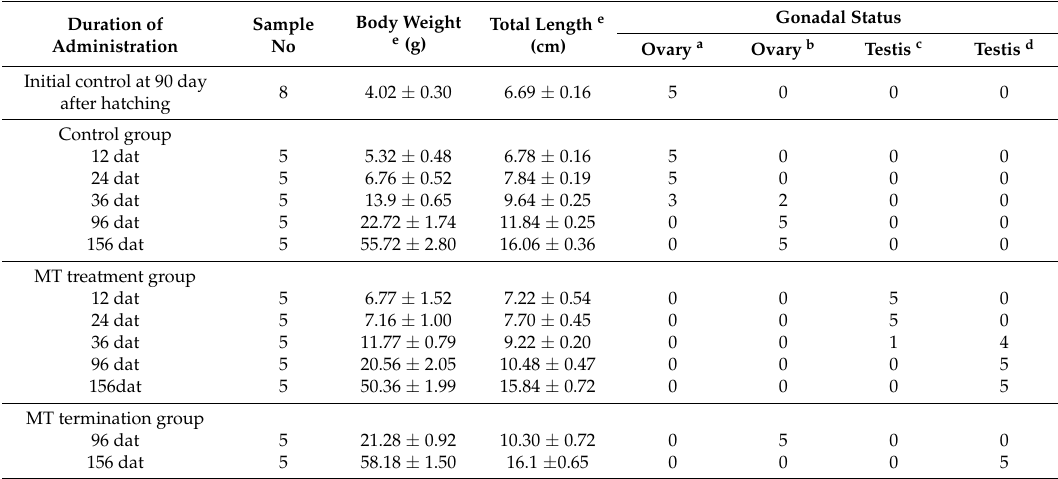
Table 1. The size and gonadal status of Epinephelus coioides during experimental period. Body Weight Total Length e Duration of Sample e (g) (cm) Administration No Initial control at 90 day after